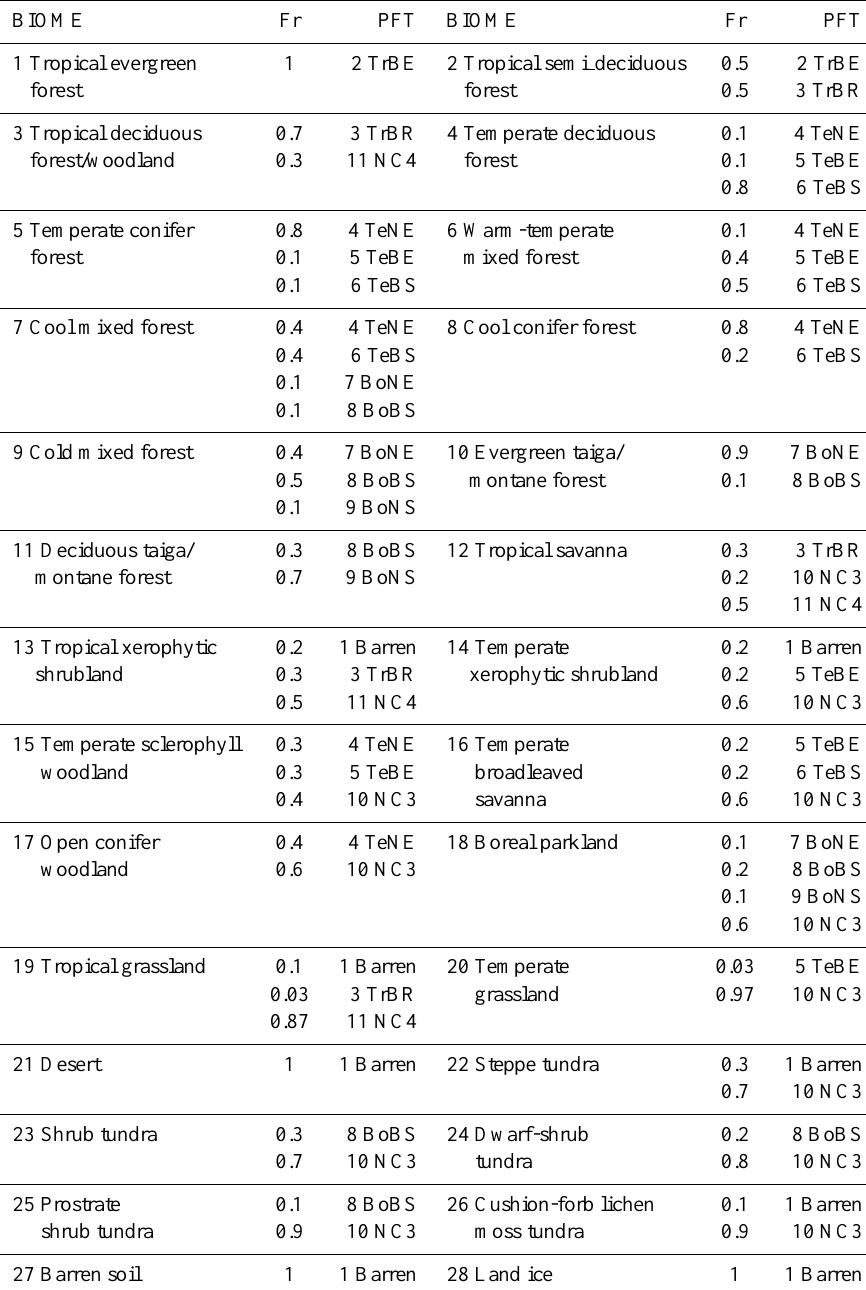
Table 1. Conversion of biomes from PRISM3 to ORCHIDEE’s Plant Functional Types (Krinner et al., 2012). For the presence of one biome on a grid cell, is attributed a fractional value of one or several PFTs. The sum of the 11 PFT fractions (Fr) on each grid cell must be equal to 1. PFT1 = barren soil/desert. PFT2 = TrBE : Tropical Broadleaf Evergreen trees. PFT3 = TrBR: Tropical Broadleaf Raingreen trees. PFT4 = TeNE: Temperate Needleleaf Evergreen trees. PFT5 = TeBE: Temperate Broadleaf Evergreen trees. PFT6 = TeBS: Temperate Broadleaf Summergreen trees. PFT7 = BoNE: Boreal Needleleaf Evergreen trees. PFT8 = BoBS: Boreal Broadleaf Summergreen